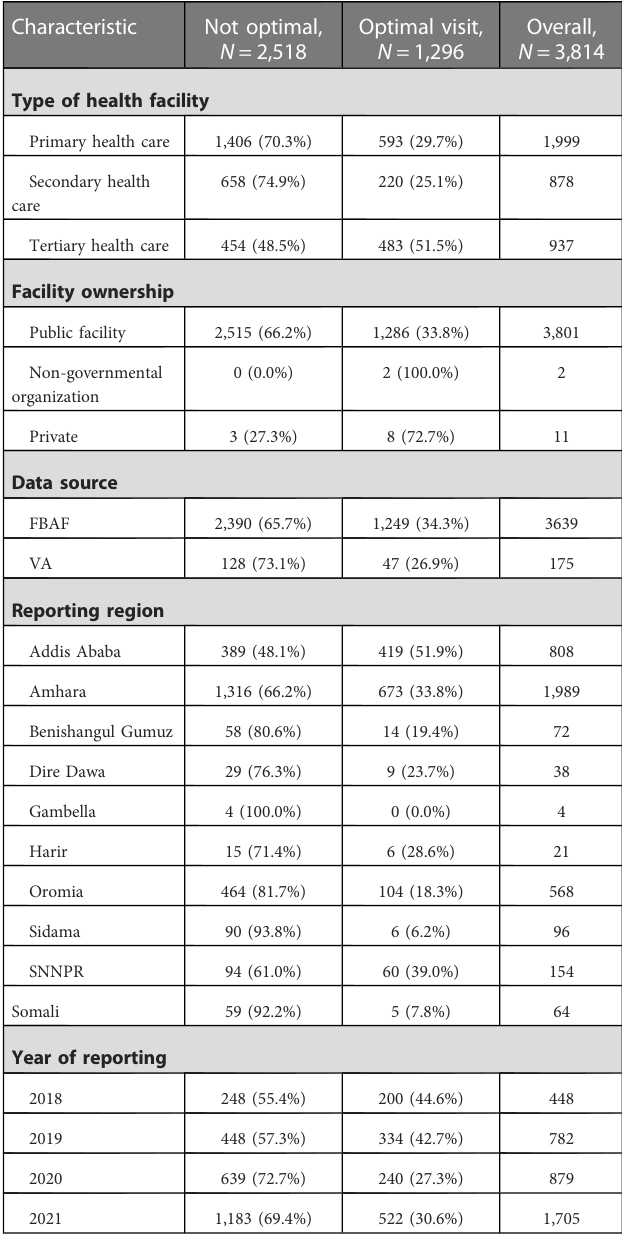
TABLE 2 Selected background characteristics of reporting facilities by the level of ANC follow-up in Ethiopia, 2021.